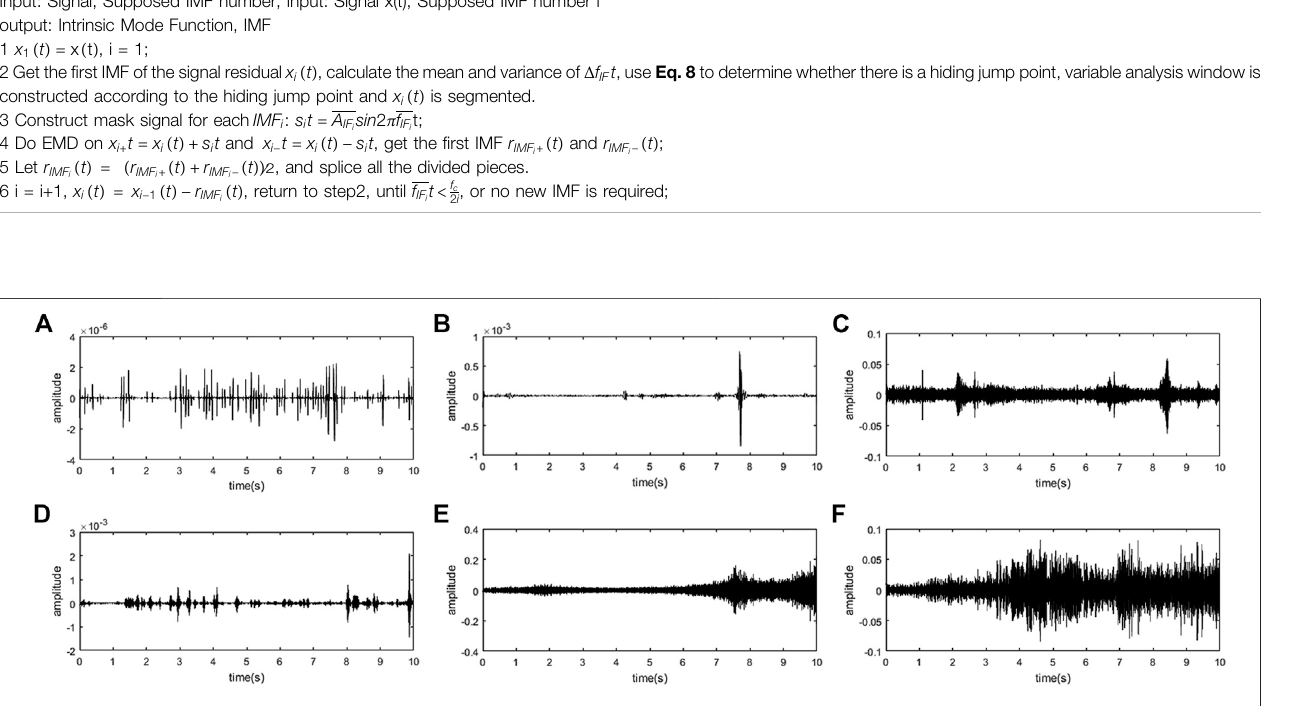
FIGURE4| IMF waveforms withsigni fi canthiddencomponents indifferentenvironments oftheaudio stream, (A) Airportluggage roller – IMF16, lowfreq; (B) Metro rail joint collision – IMF14, low freq; (C) Chirm – IMF1, high freq; (D) steps – IMF10, medium freq; (E) Vehicles from far to near – IMF1, high freq; (F) Tram acceleration – IMF4, Medium and high freq.